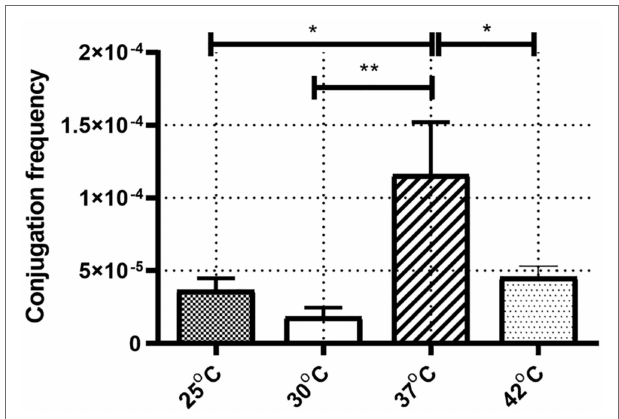
FIGURE 1 | The conjugation frequency of IncX3 at four corresponding temperature. The conjugation frequency was calculated as transconjugants per recipient. Error bars indicate the standard deviations for six triplicate samples. * p < 0.05/** p < 0.01 versus the result for conjugation frequency at 37 °